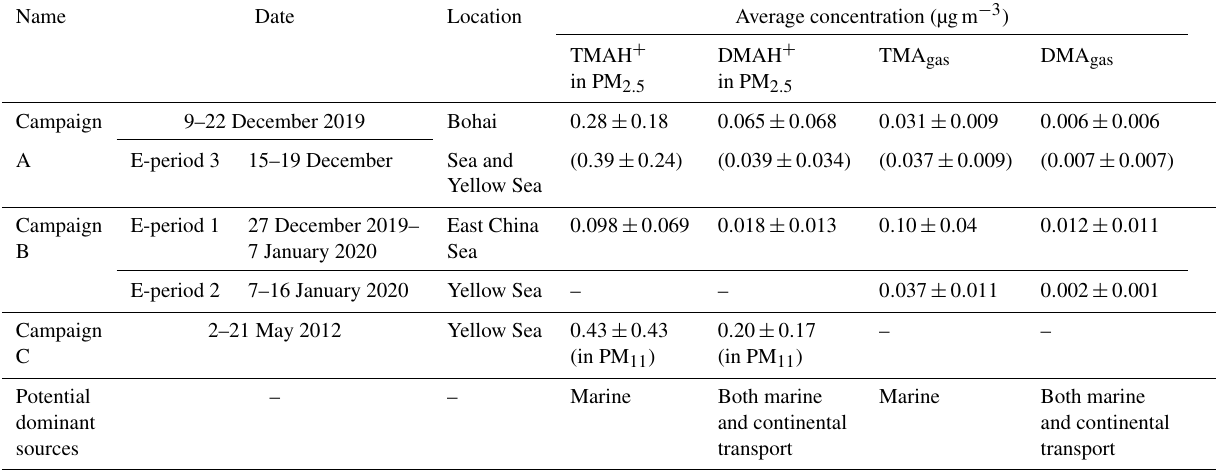
Table 1. Information on the three campaigns and concentrations of TMA gas and DMA gas and their particulate partners in PM 2 . 5 (aver- age ± standard